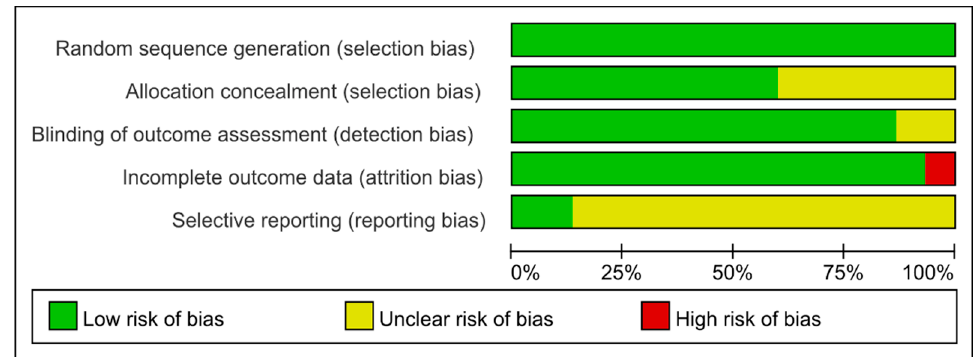
Figure 2. Risk of bias graph: review authors’ judgements about each risk of bias item presented as percentages across all included studies. Table 1. Characteristics of the included studies.